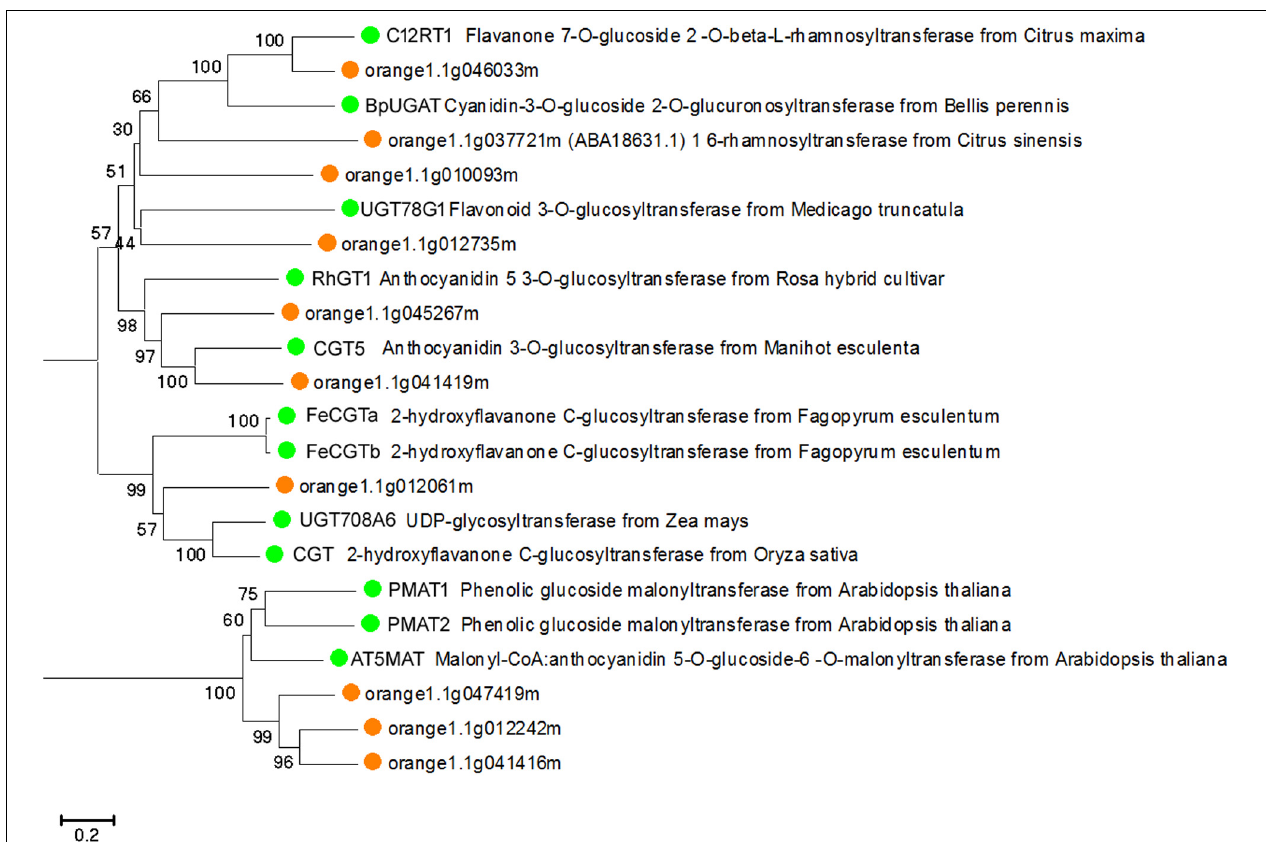
FIGURE 3 | Phylogenetic tree based on the full-length proteins of 10 Citrus and 12 functionally characterized UGT proteins. Gene names and accession numbers: C12RT1 (AY048882), BpUGAT (AB190262), UGT78G1 (XM_003610115), Cs1,6Rhat (DQ119035), RhGT1 (AB201048), CGT5 (X77462), FeCGTa (AB909375), FeCGTb (AB909376), UGT708A6 (NM_001139178), CGT (FM179712), PMAT1 (NM_123267), PMAT2 (NM_113889), AT5MAT (NM_113880). Bootstrap values are shown above the nodes.